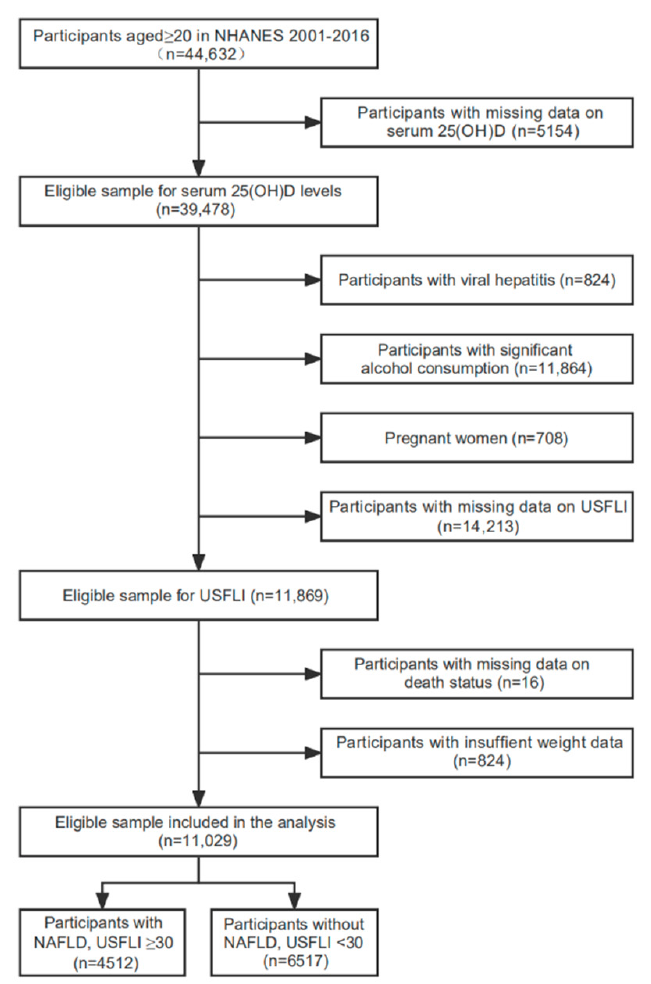
Figure 1. Flowchart of participant selection. Abbreviations: NAFLD, nonalcoholic fatty liver disease; NHANES, National Health, and Nutrition Examination Survey; USFLI, US fatty liver index.